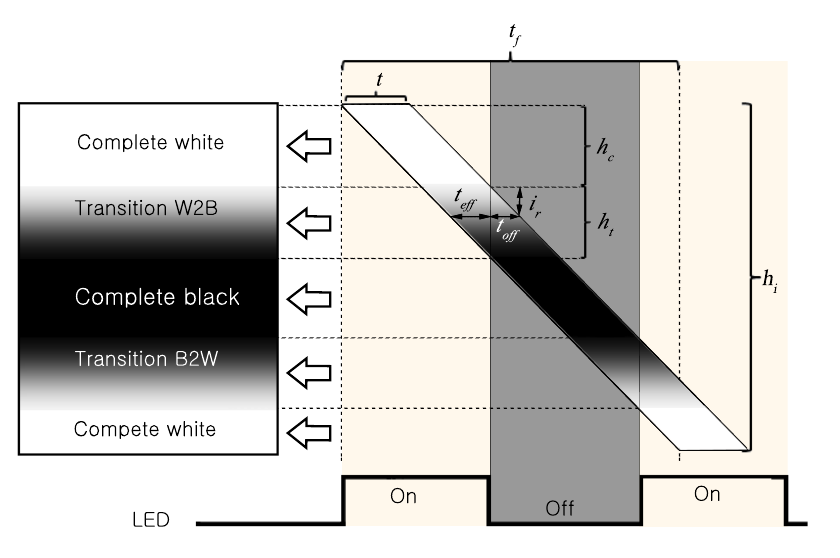
Figure 5. Transition between white and black